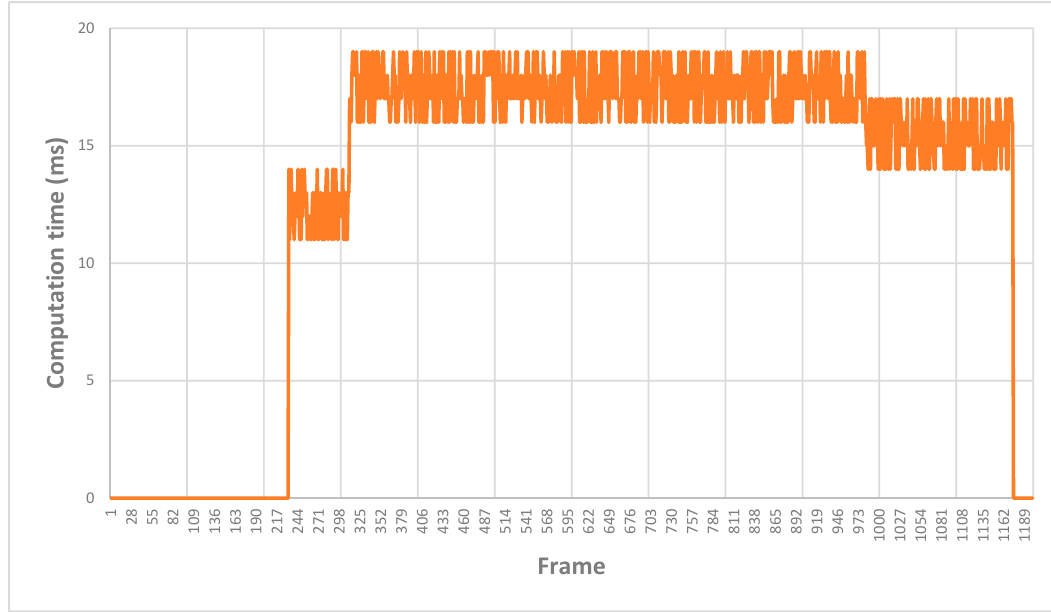
21 of 27 Figure 23. Actual landing spot versus landing goal.